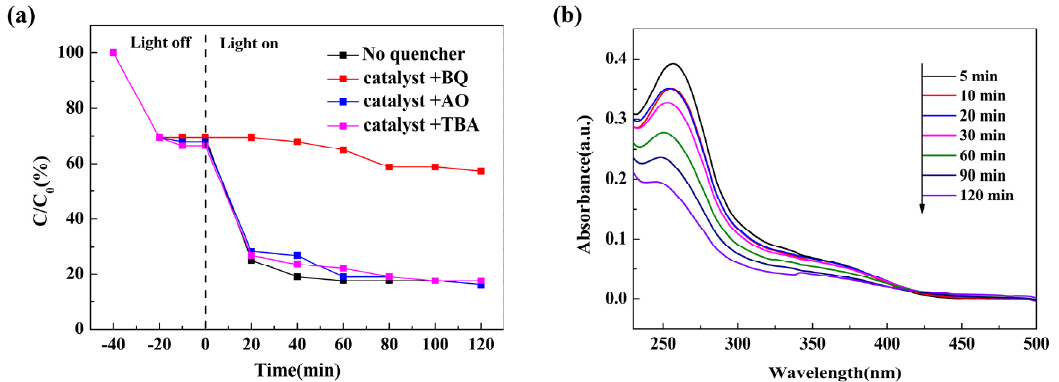
Figure 12. ( a ) Trapping experiments of actives species for TC over 80ZIS/CN the photocatalytic degradation curve during 120 min, ( b ) UV − vis absorbance spectra of Nitro Blue tetrazolium aqueous solution containing 200 mg/L of 80ZIS/CN photocatalyst.